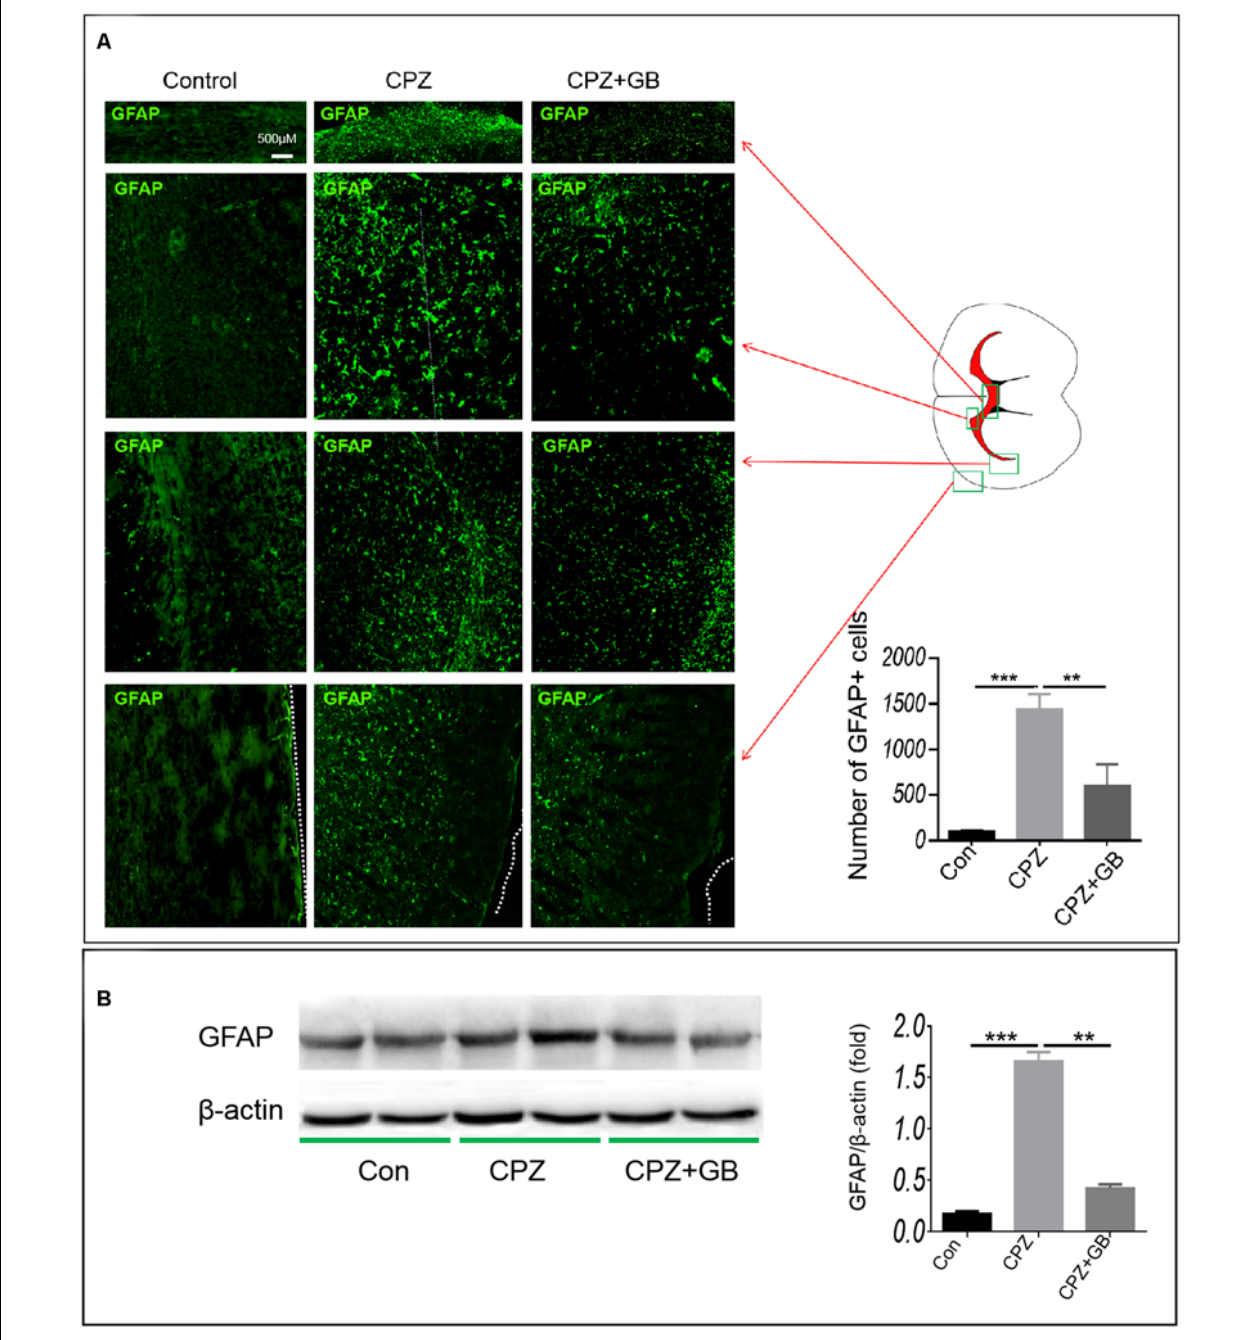
FIGURE 6 | GB inhibited astrocyte response. Mice were fed with chow containing 0.2% CPZ for 6 weeks and were intraperitoneally injected with GB for 14 consecutive days from the 4th to 6th week of CPZ feeding. (A) Distribution of GFAP + astrocytes in the corpus callosum, claustrum, cingulate cortex and cortex of the brain by immunohistochemistry, (B) expression of GFAP protein in the extract of the brain by western blot. Representative images are obtained from three to four mice/each group, with similar results. The results represent the mean ± SEM. ∗∗ p < 0.01, ∗∗∗ p <